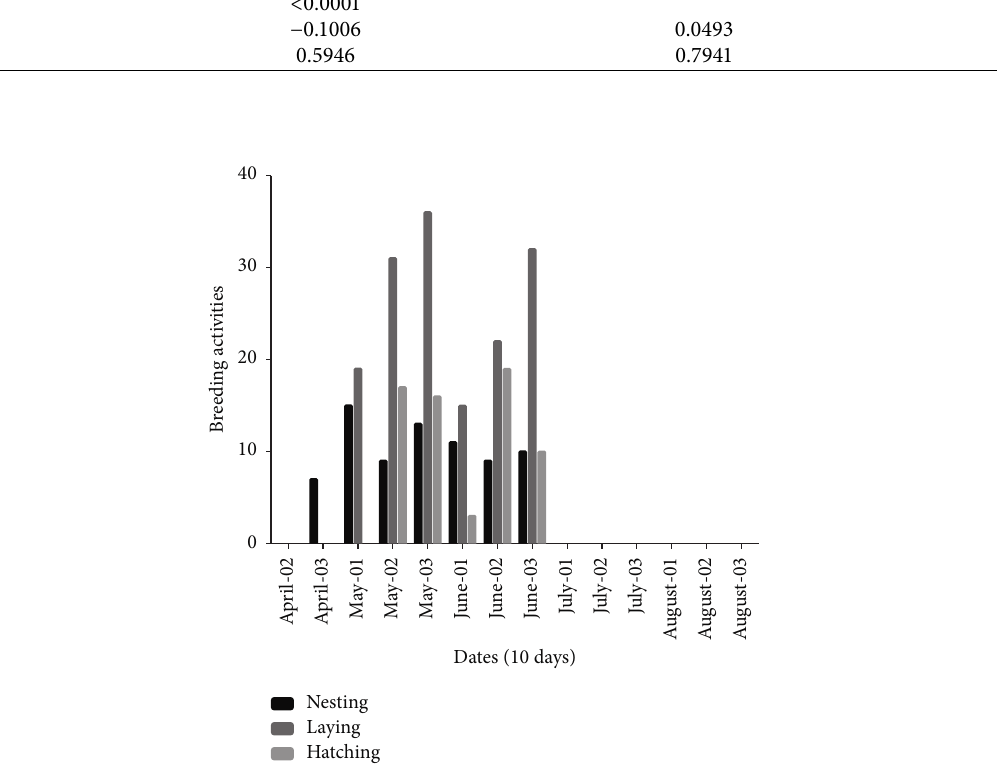
Figure 4: Breeding chronology of the Common Blackbird at the Ait Ayach